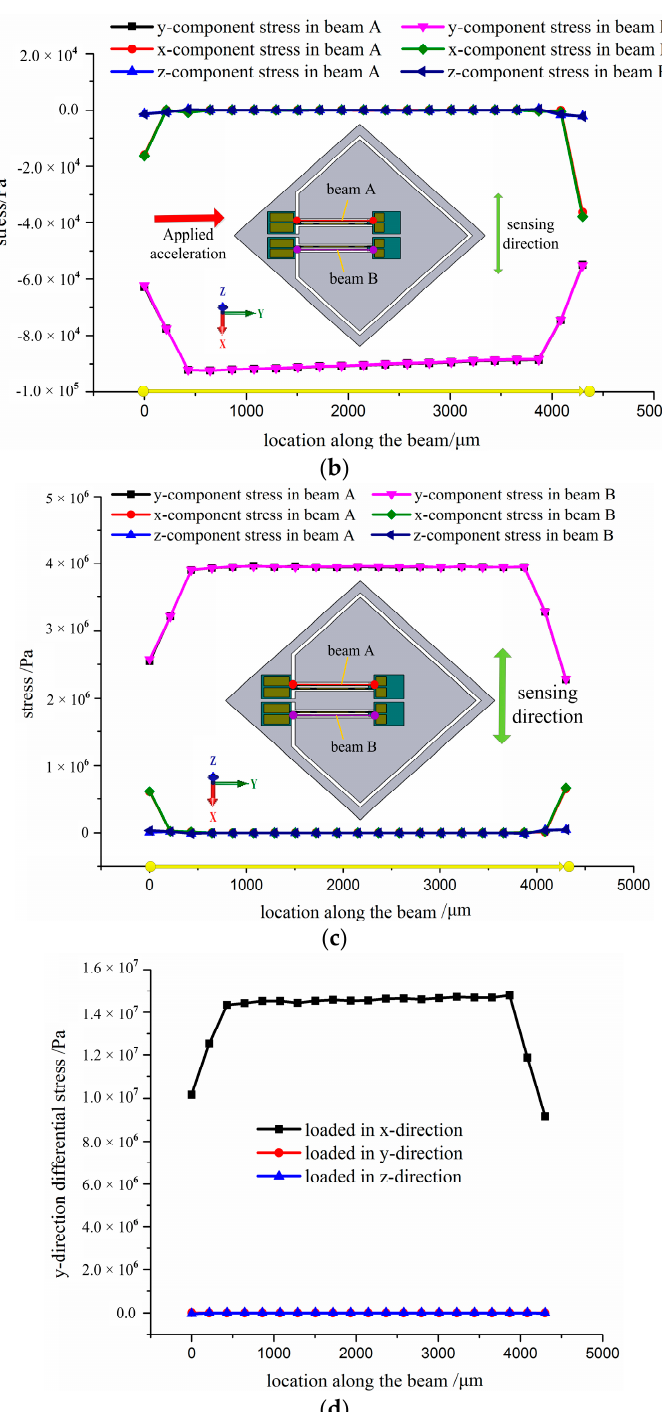
Figure 8. Simulation results of stress in the DETF beam along the selective pass: ( a ) loaded in x -direction; ( b ) loaded in y-direction; ( c ) loaded in z-direction; and ( d ) differential stress along the axial direction of the EDTFs.